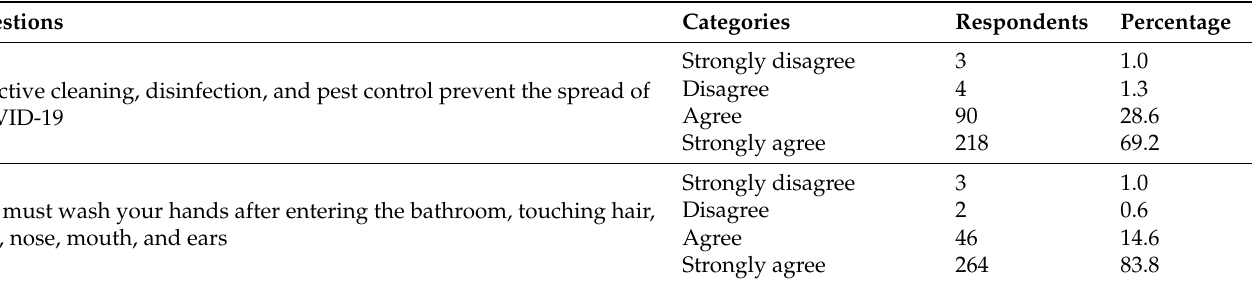
Table 3. Knowledge level of food service staff on hygiene and standard